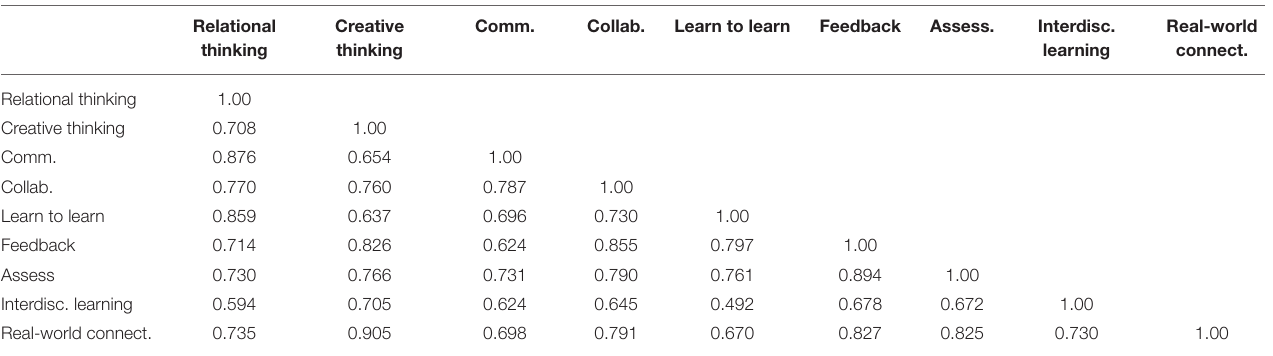
TABLE 5 | Latent correlations among model